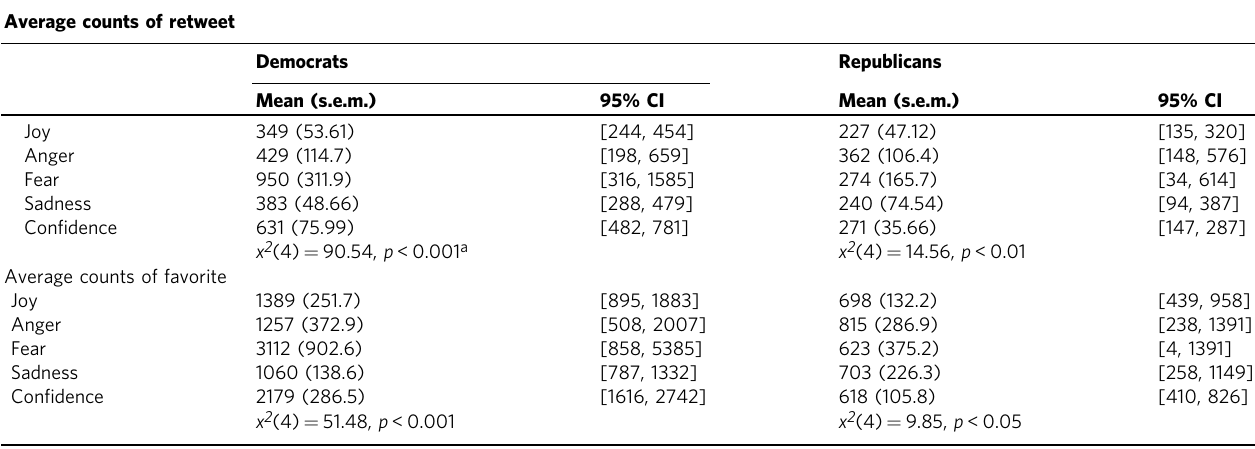
Table 2 Comparison of emotive posts on retweets and